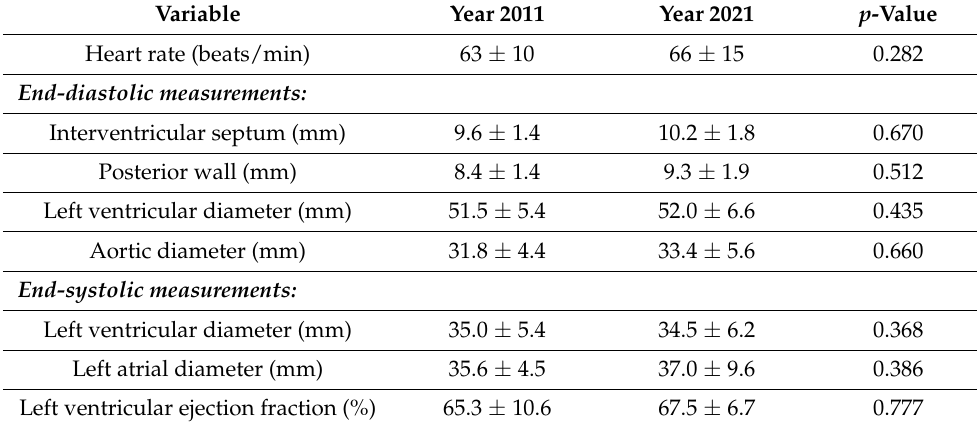
Table 2. Echocardiographic and Doppler measurements in 2011 and 2021. Data are expressed in mean ± standard